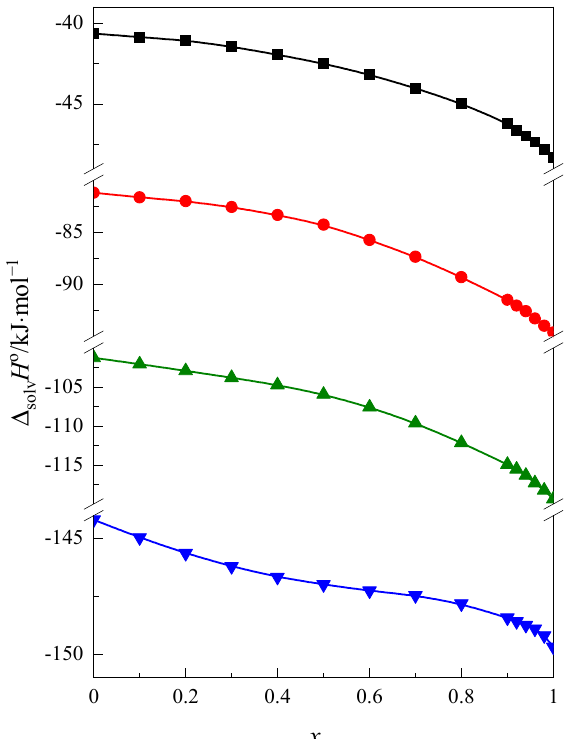
Figure 3. The standard solvation enthalpy of 1,4-dioxane, (cid:4) ; 12C4 • ; 15C5, (cid:78) ; and 18C6, (cid:72) in the F + W mixture at 298.15 K.